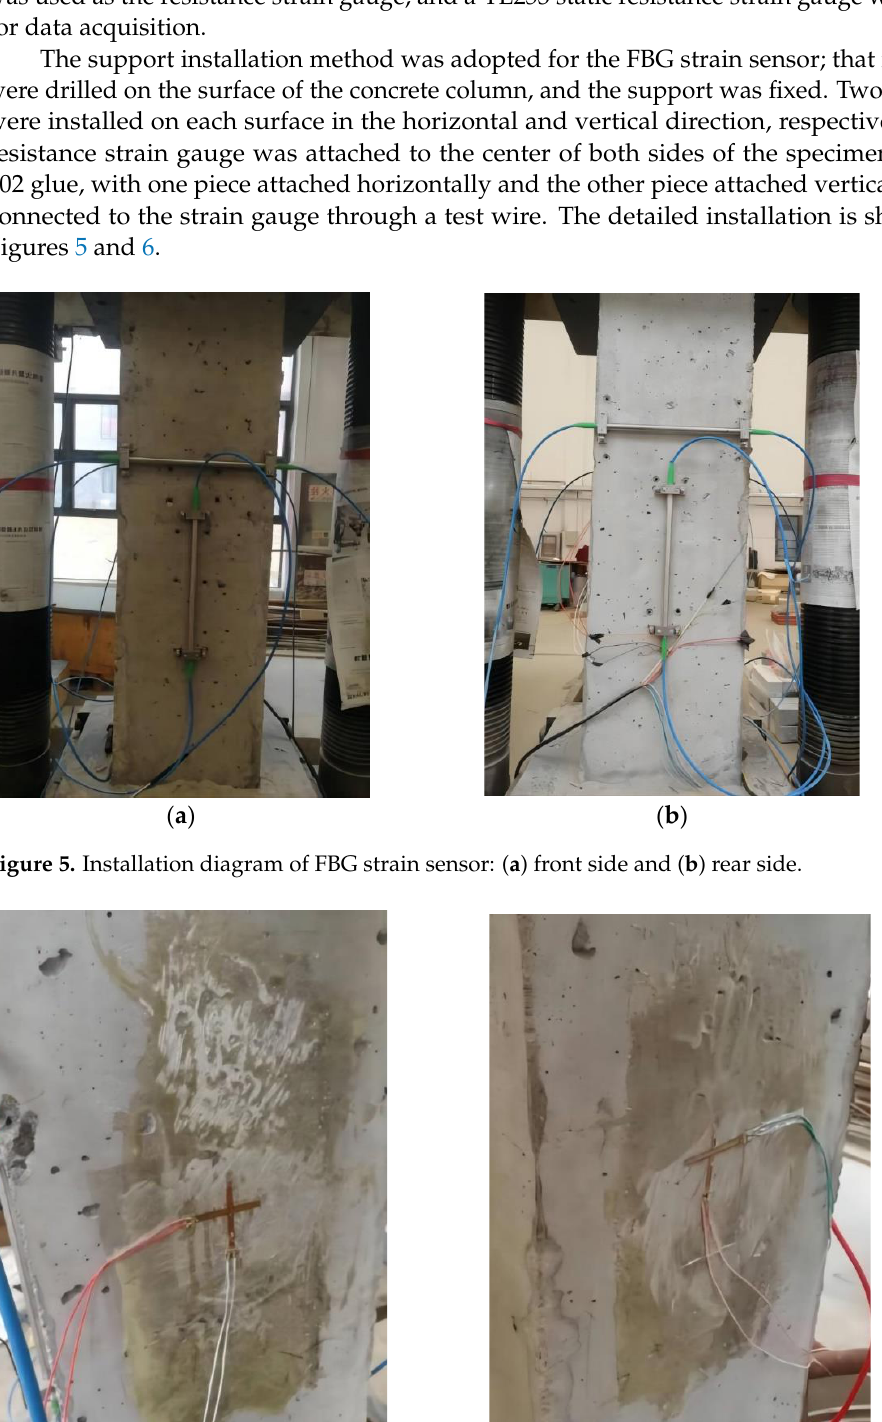
Figure 4. NZS-FBG-A04 multichannel fiber grating demodulator.